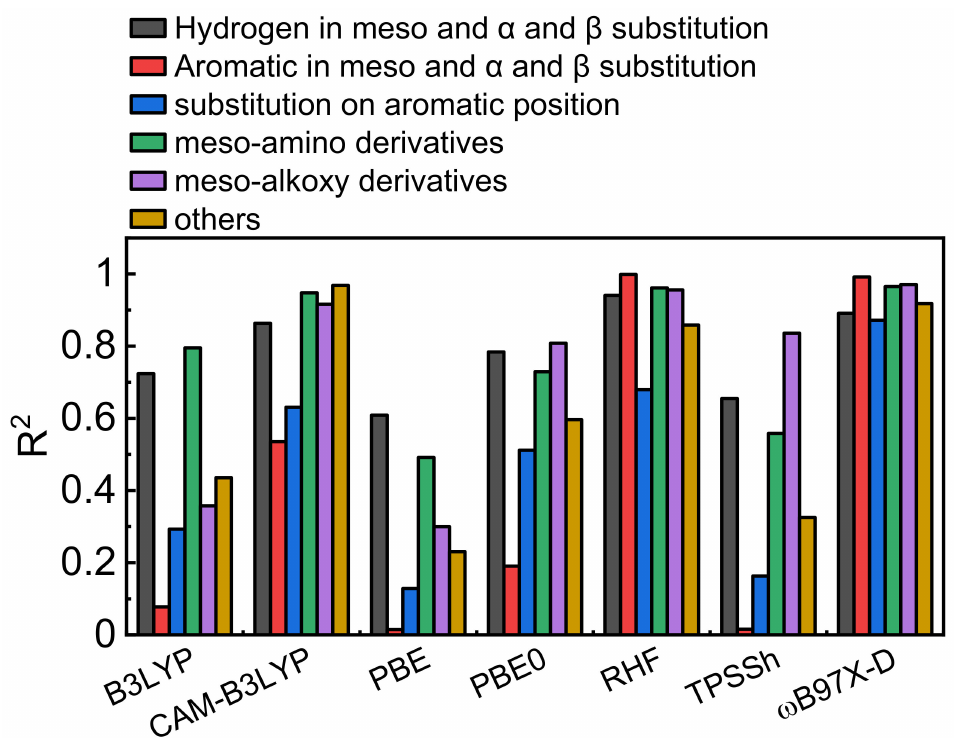
Figure 4. Correlation between R 2 and the computational method for each family of BODIPY derivatives. Dark grey: No substituent placed at the meso, α , and β positions. Red: Aromatic groups placed at the meso, α , and β positions. Blue: Various substitutions placed on the aromatics. Green: Amino groups placed at the meso position. Brown: Other